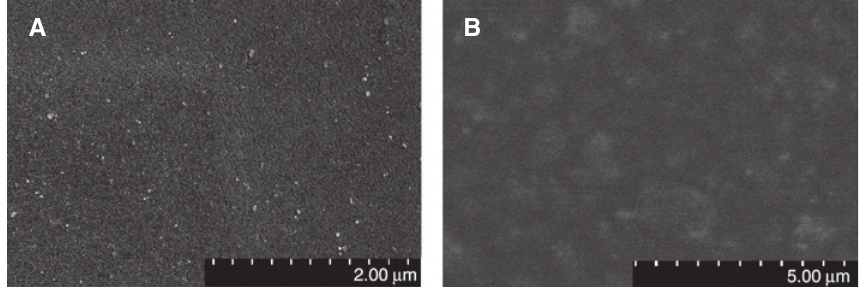
Figure 4: SEM micrographs of fracture surface of SPUA8 (A) and SPUA0 (B)